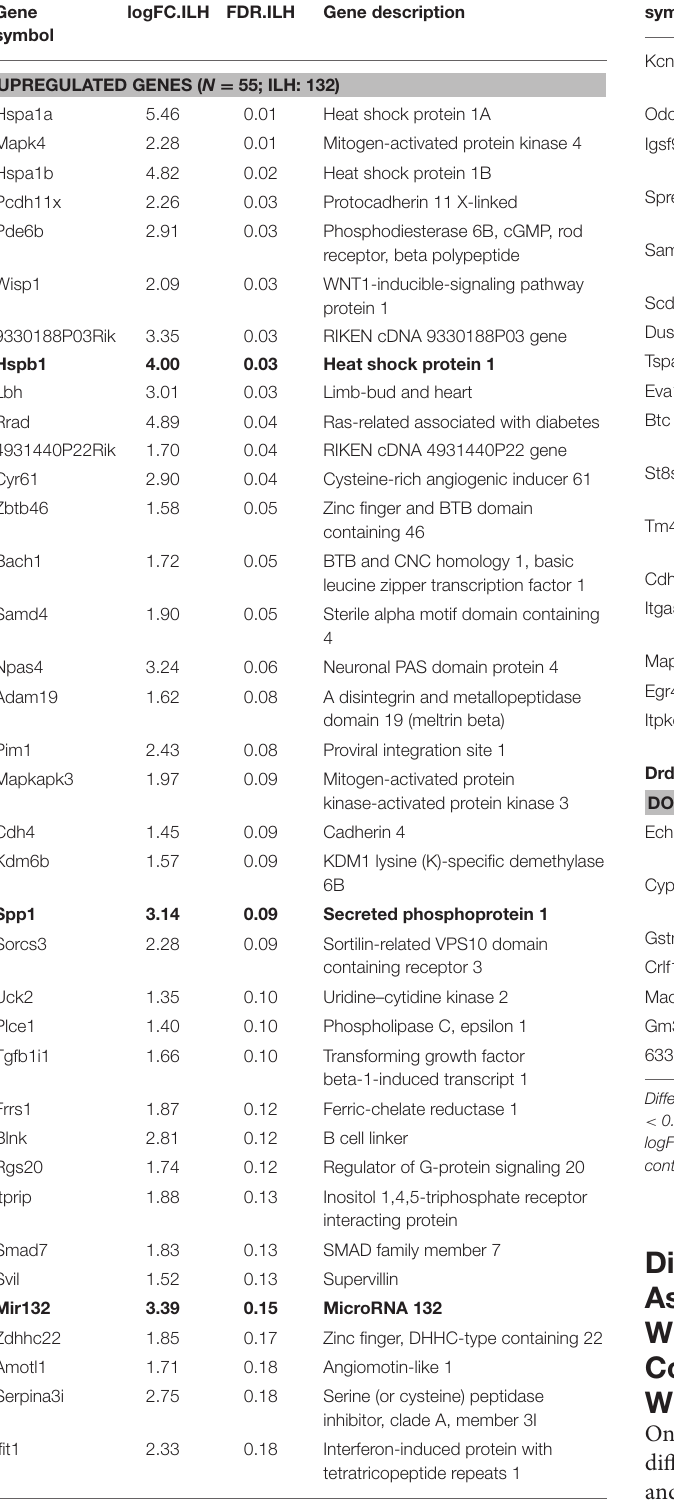
TABLE 5 | Differentially expressed genes in neurons exclusively in the ILH (and not the CLH) at 24h after kainate-induced status epilepticus. Gene logFC.ILH symbol